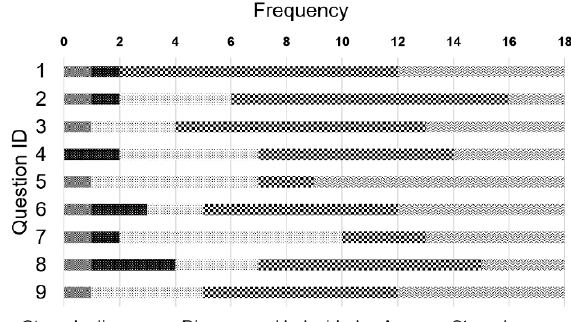
Figure 5. Results of the first nine